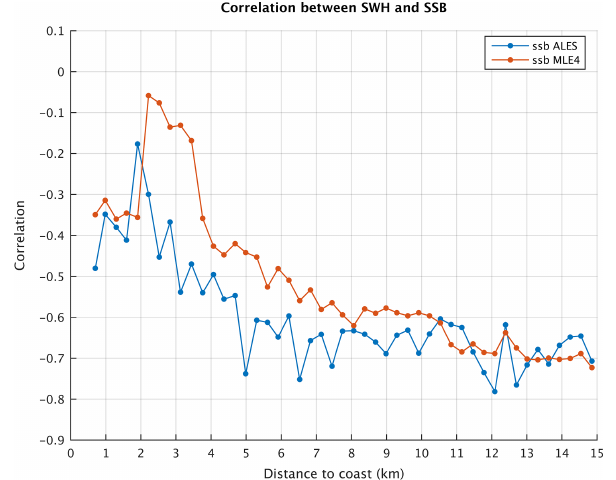
Figure 17. Correlation between significant wave height (SWH) time series and ssb time series between every 20Hz point and a reference point.